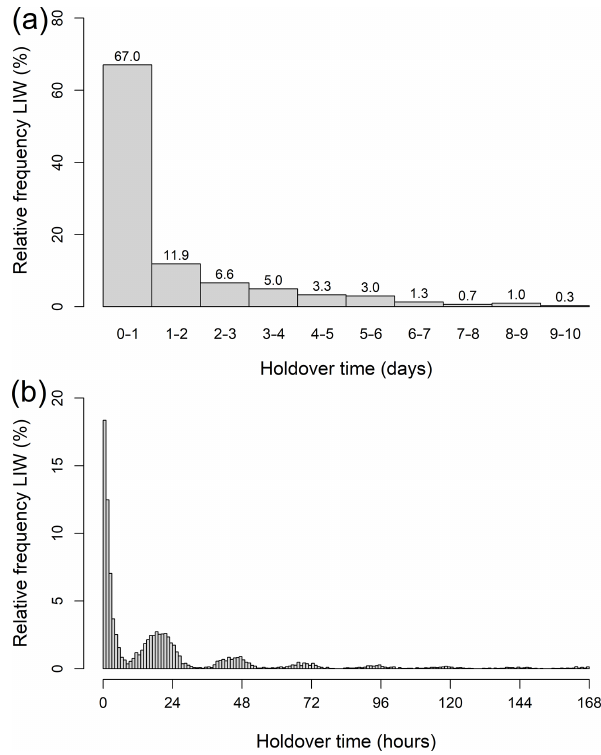
Figure 1. Examples of frequency distributions (i.e., censored datasets) of LIW holdover time from the database. (a) Daily fre- quency distribution obtained from 303 LIWs that occurred in Aus- tria between 2013 and 2020 (Müller and Vacik, 2017). (b) Hourly frequency distribution obtained from 6301 LIWs that occurred in Arizona and New Mexico between 2009 and 2013 (Pérez-Invernón et al.,